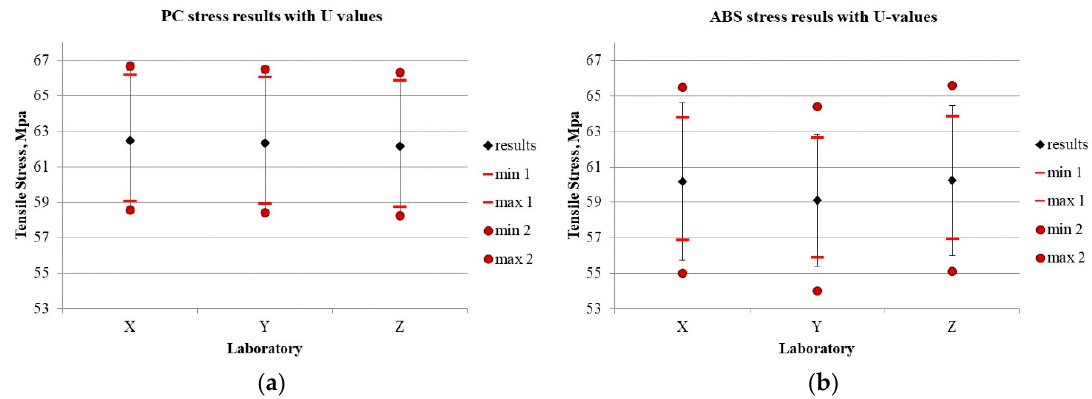
Figure 5. Tensile strength results with U value for three laboratories (X, Y, Z) and two materials ( a ) PC, ( b ) ABS. Black error bars are based on actual standard deviation (approach II). Points min 1 and max 1 are 95% coverage intervals obtained in approach I (only B-uncertainty of F and D values), points min 2 and max 2 are 95% coverage intervals obtained by the Monte Carlo method in approach IV, where reproducibility standard deviation is obtained from ISO 527-2 standard.